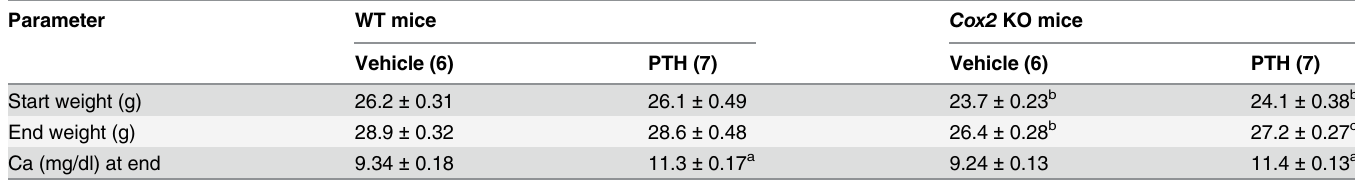
Table 5. Body weight and serum calcium (Ca) in 3-mo old wild type (WT) and Cox2 KO mice infused with vehicle or PTH for 21 days. Parameter